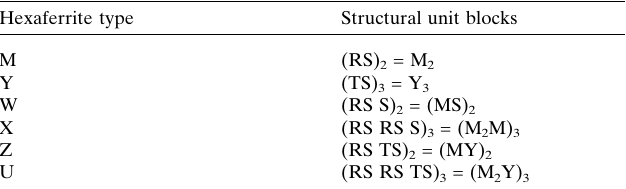
Table 2 Description of known hexaferrite unit cells from the R, S and T fundamental unit blocks, and the larger M and Y building blocks.